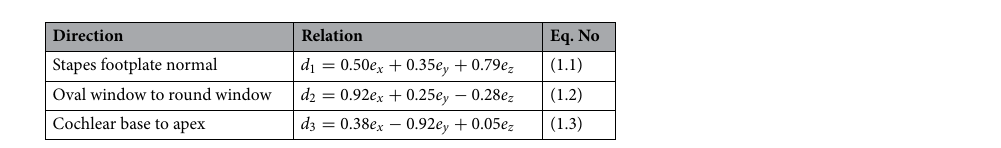
Table 1. The directions of the cochlear vectors in Fig. 1 in relation to the overall coordinate system. e x , e y , and e z are the base vectors for the x, y and z directions, respectively.